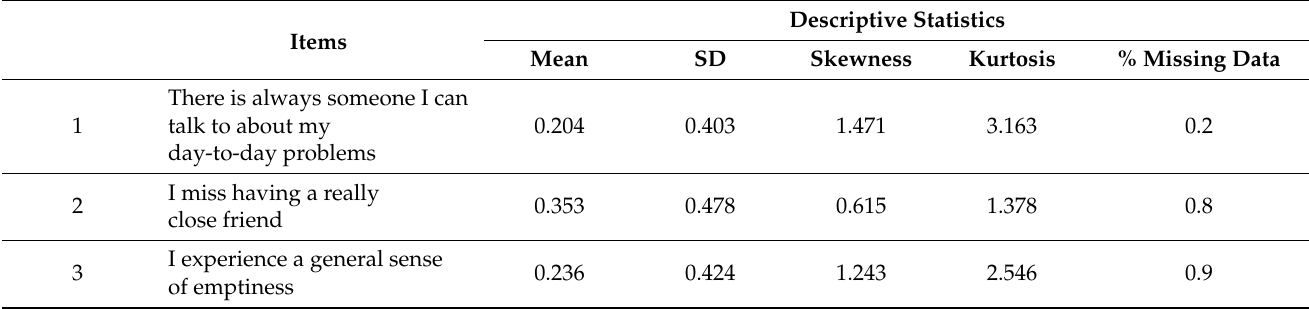
Table 3. Descriptive statistics of the DJGLS